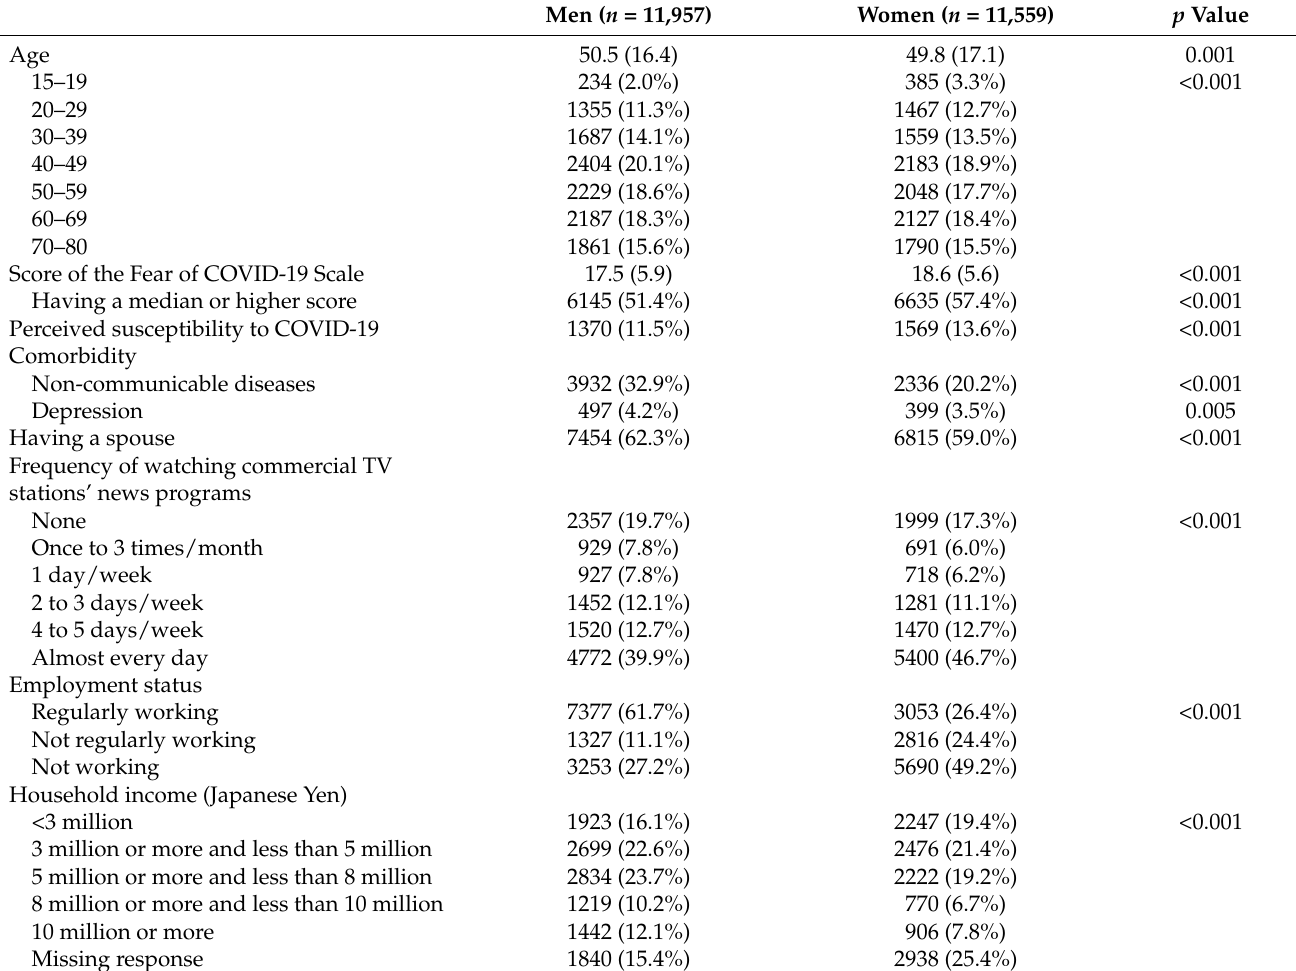
Table 1. Characteristics of subjects.